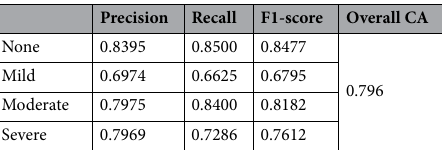
Table 4. Values of the generalization performance of the classification using the SVM classifier. CA: classification accuracy.